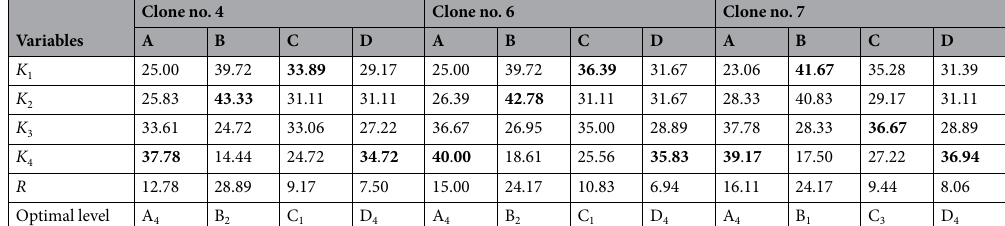
Table 5. Range analysis of L 16 (4) 4 test results for bud germination rate. The optimal level is in bold.